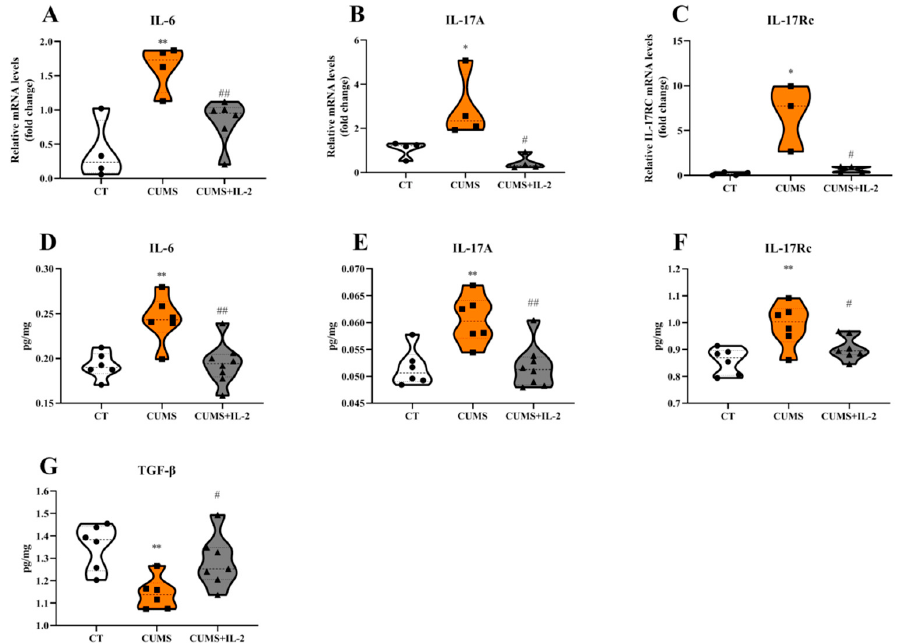
Figure 4. IL-2 reduced the mRNA and protein expression of central pro-inflammatory factors and IL-17A receptor in the mouse hippocampus after CUMS exposure. IL-6 ( A , D ), IL-17A ( B , E ), IL-17Rc ( C , F ) and TGF- β ( G ) (n = 3–8). CT, control group; CUMS, CUMS group; CUMS+IL-2, CUMS exposure with IL-2 treatment. ** p < 0.01, * p < 0.05 vs. CT; # p < 0.05, ## p < 0.01 vs. CUMS.